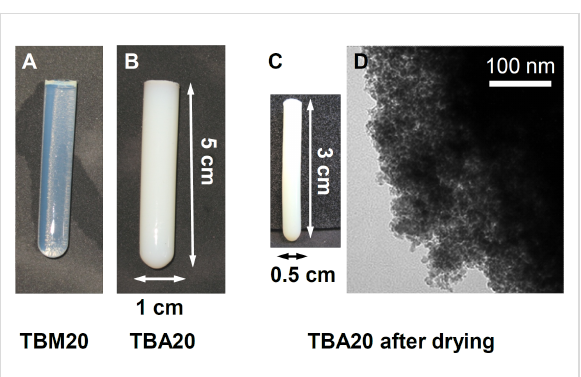
Figure 2: Representative photographs and TEM images of organo- silica monoliths. (A) Wet TBM20 after Soxhlet extraction with metha- nol, (B) wet TBA20 after Soxhlet extraction with methanol, (C) dry TBA20 after drying at ambient conditions, (D) TEM image of TBA20 after drying.